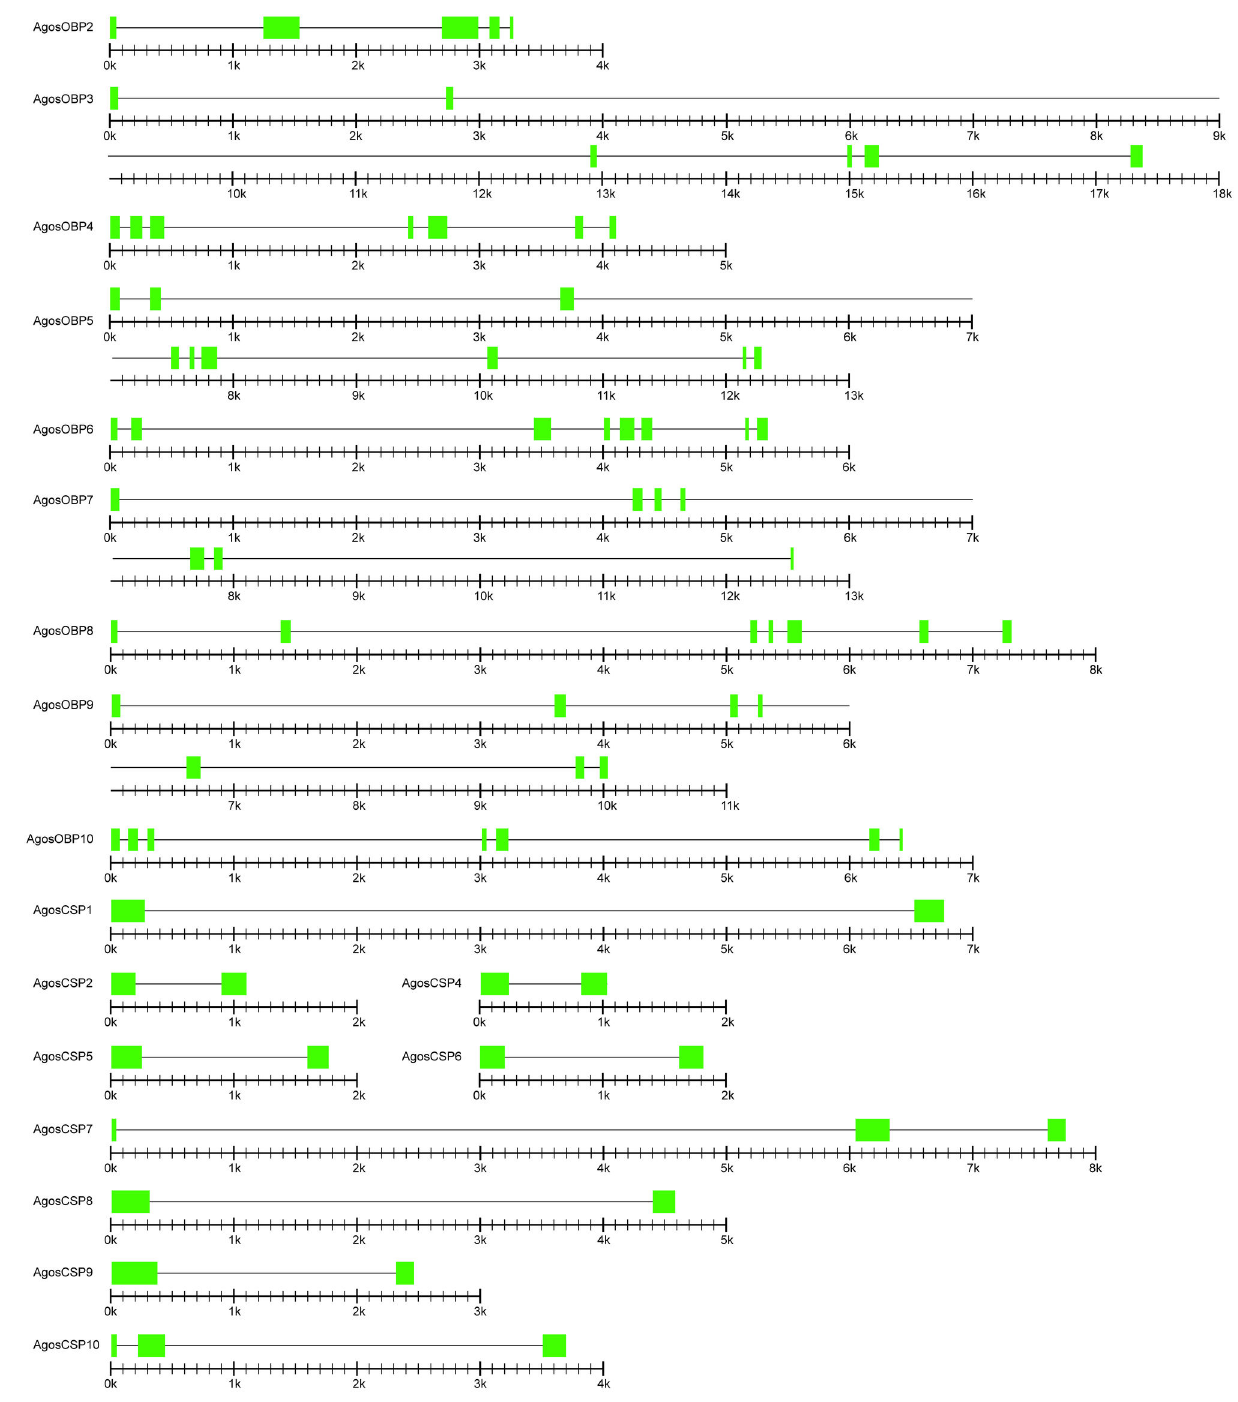
Figure 3. Genomic structure of A . gossypii OBP and CSP genes . The genomic structure of each A . gossypii OBP and CSP was analyzed by aligning the mRNA sequence with the genomic DNA sequence using Spidey program. The green rectangles and hairlines represent the extrons and introns, respectively. The scale bars are illustrated under each A . gossypii OBP and CSP with every minor mark as 100 bp and every major mark as 1 kb, respectively.